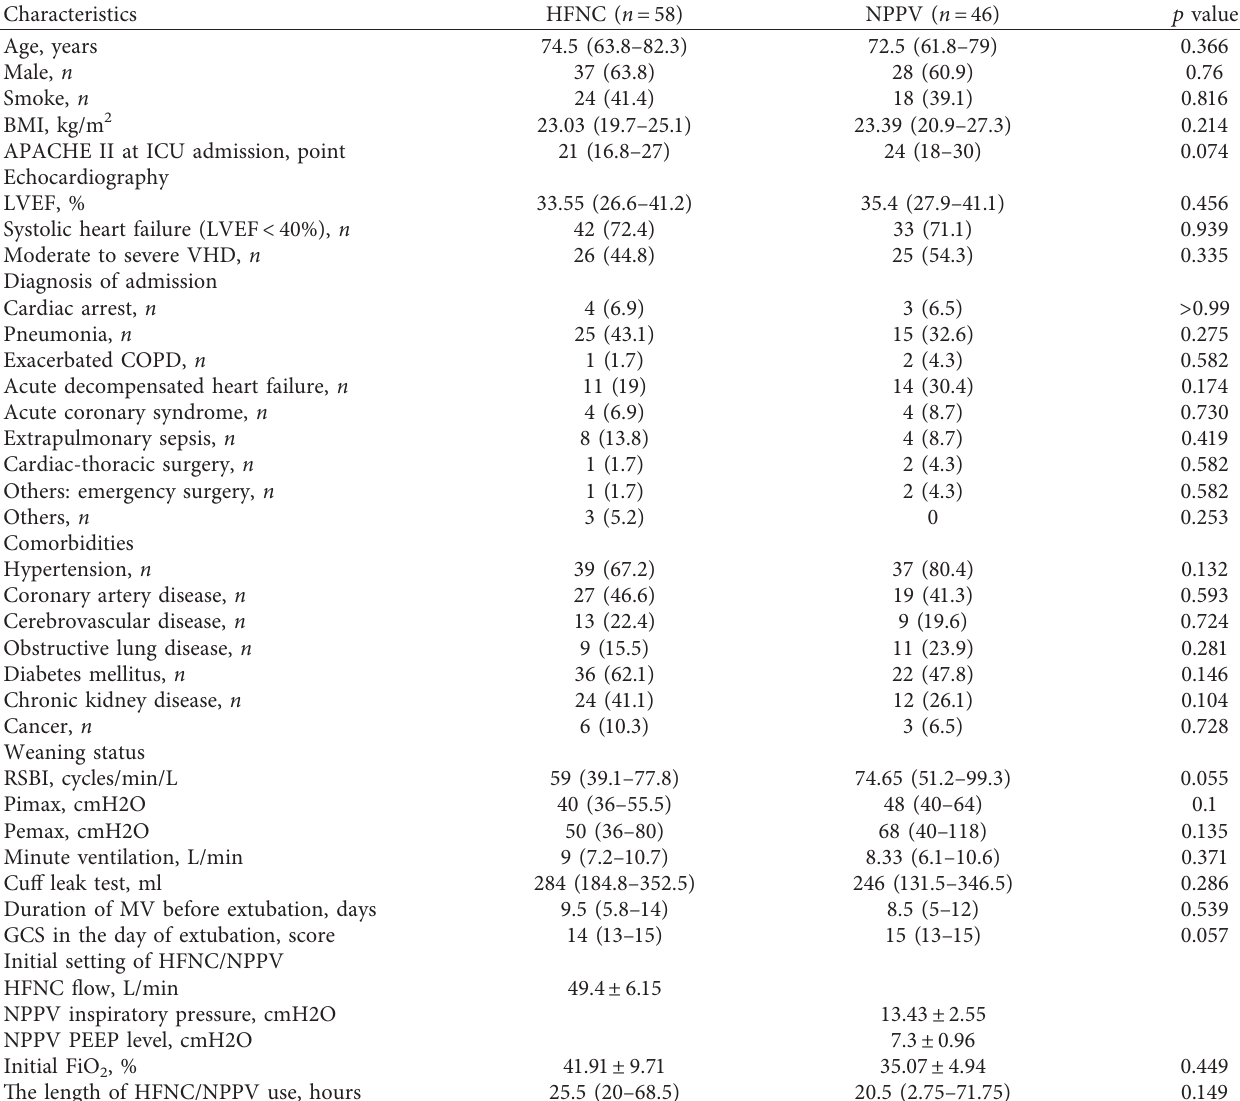
Table 1: Baseline characteristics of patients in the HFNC and NPPV